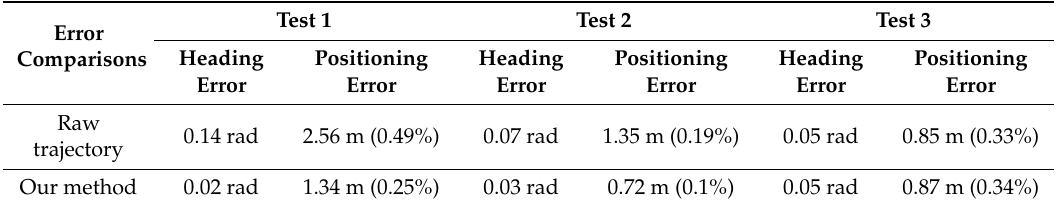
Table 1. Summary of the results from the tests with different amounts of anchor